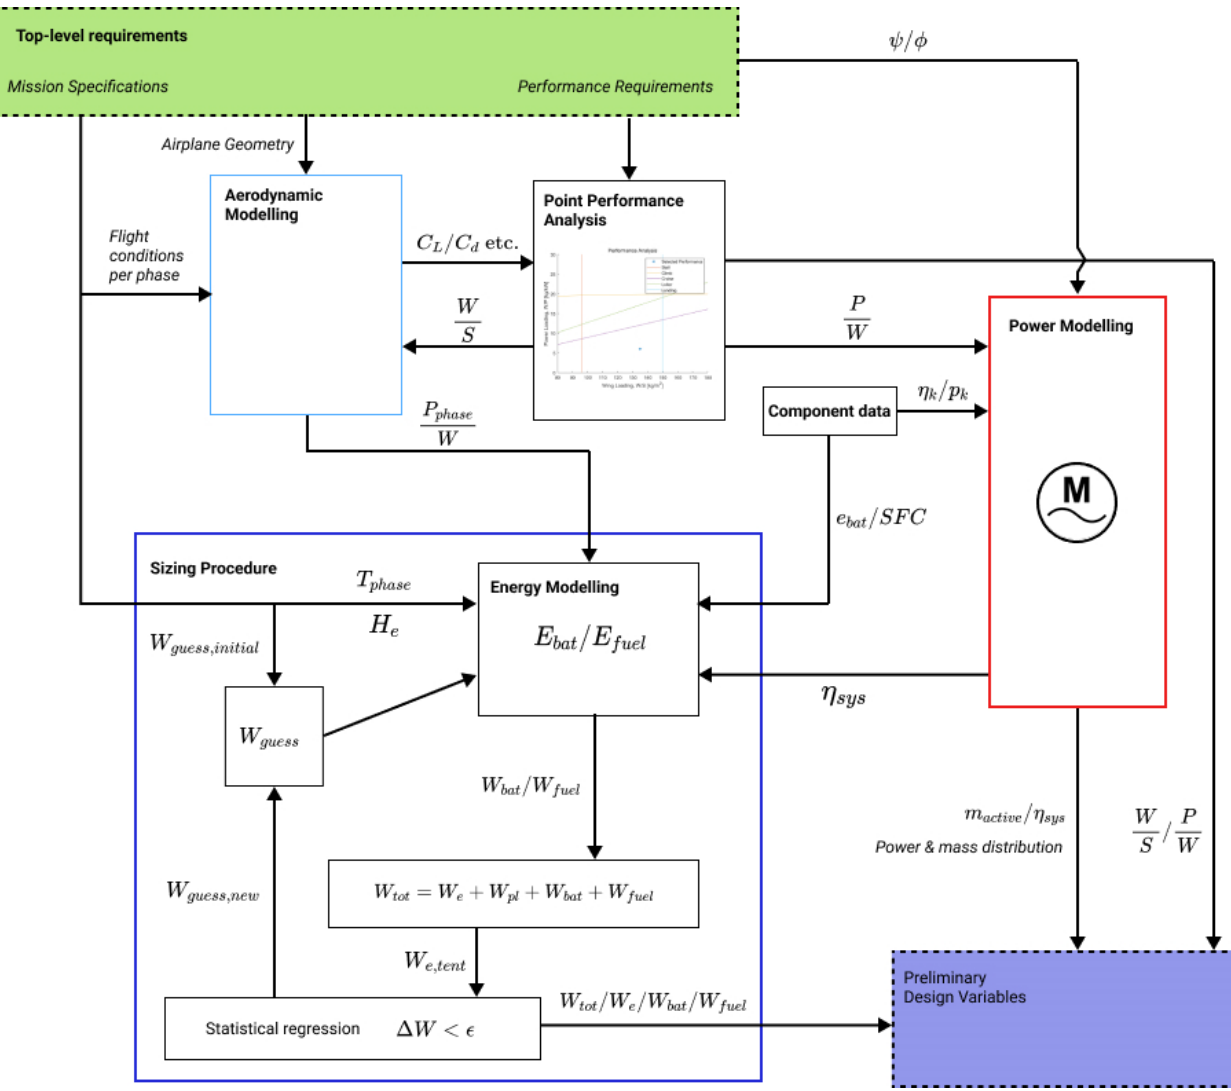
Figure 1. Methodology for calculating design variables.